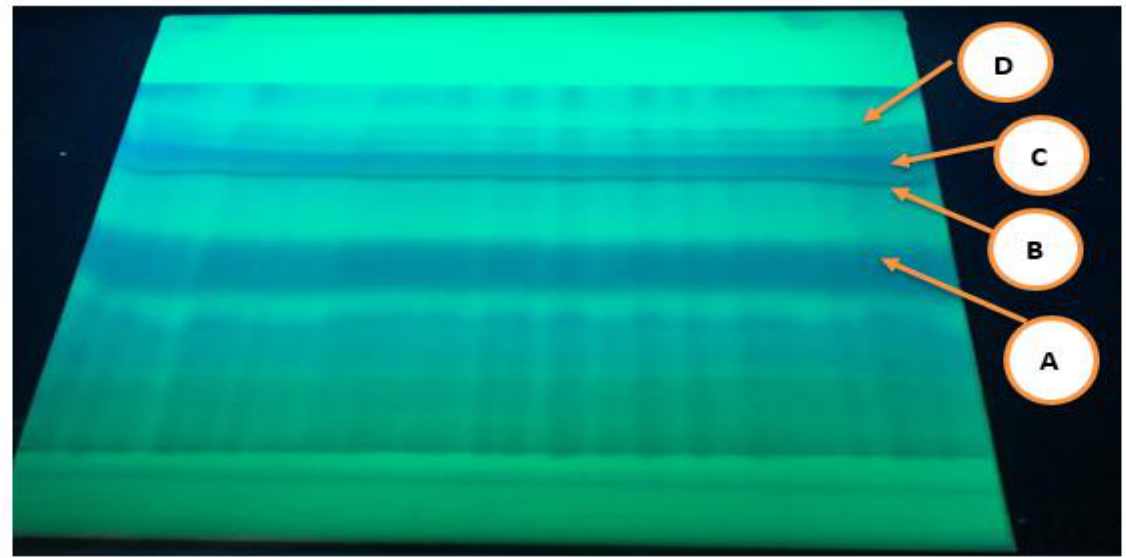
Figure 1. preparative layer chromatography for ethyl acetate fraction developed in chloroform: methanol: formic acid (75:20:5) & detect under UV light at 254 nm (A: R, B:CA, C: G, D: